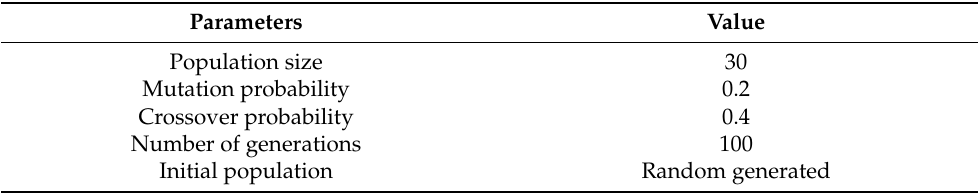
Table 2. Values of genetic algorithm parameters design.